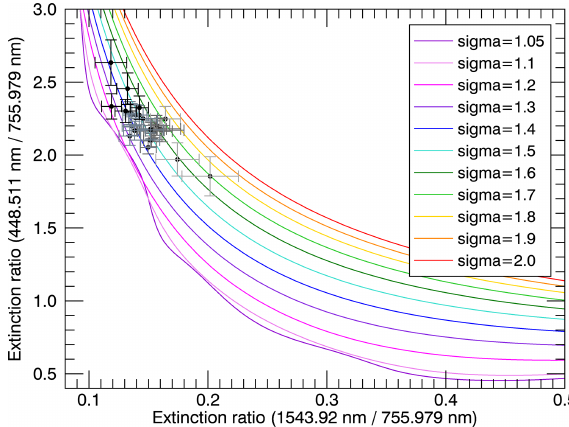
Figure 4. Extinction ratios derived from SAGE III/ISS measure- ments from one exemplary sunset event at 5.2 ◦ S and 179.6 ◦ W on 23 June 2017 plotted in the field of the same Mie calculations shown in Fig. 2a, including error bars. Each point represents measurements at a different tangent height. The darker the points and error bars depicted, the higher the corresponding tangent height of the mea-